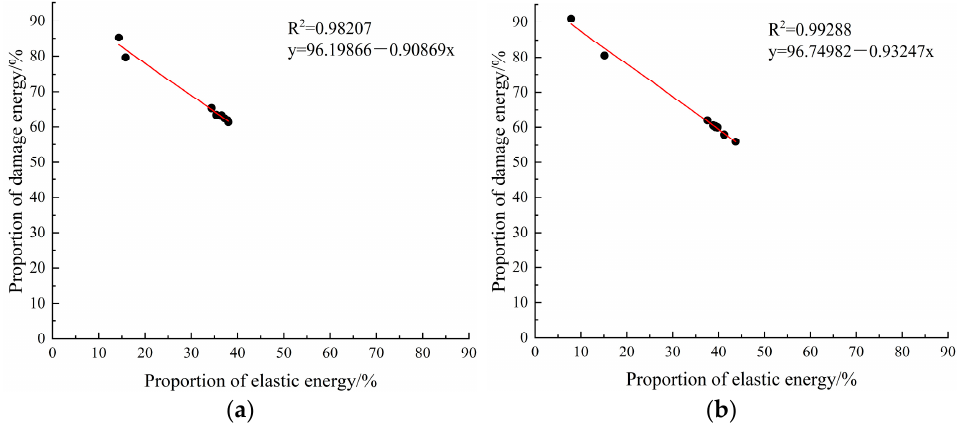
Figure 18. Fitting between the proportion of damage energy and proportion of elastic energy under VLLCL. ( a ) Sandstone; ( b ) granite.